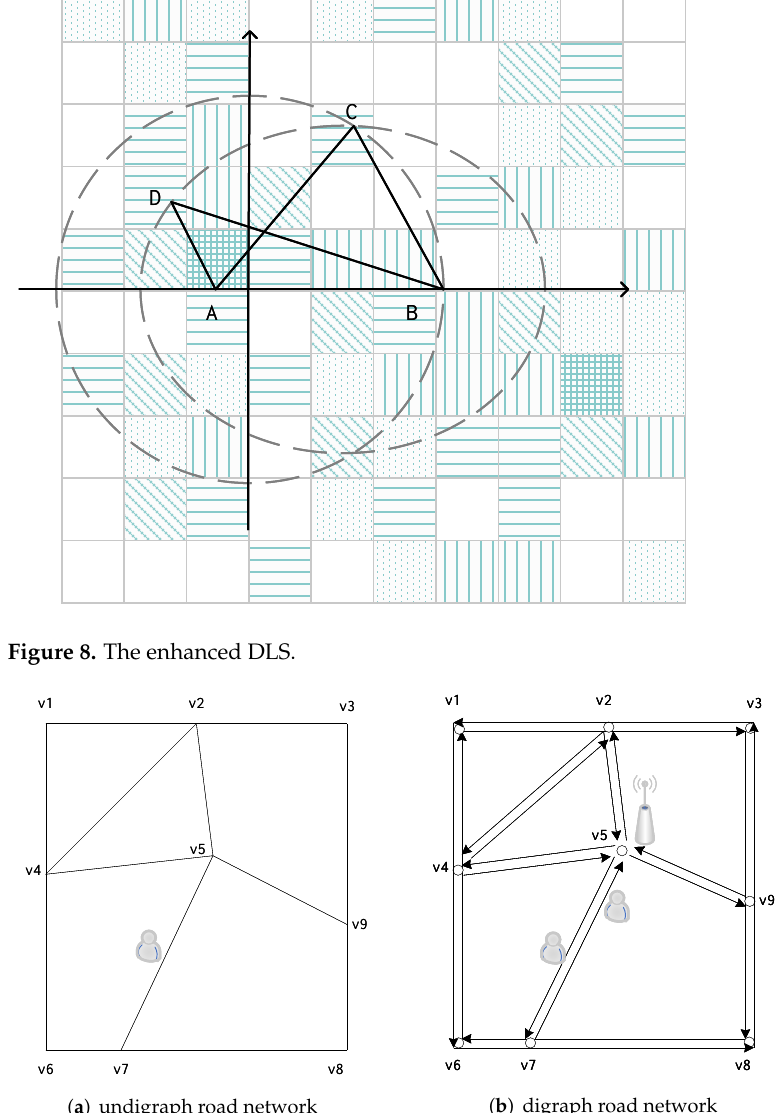
Figure 9. Undigraph/digraph road